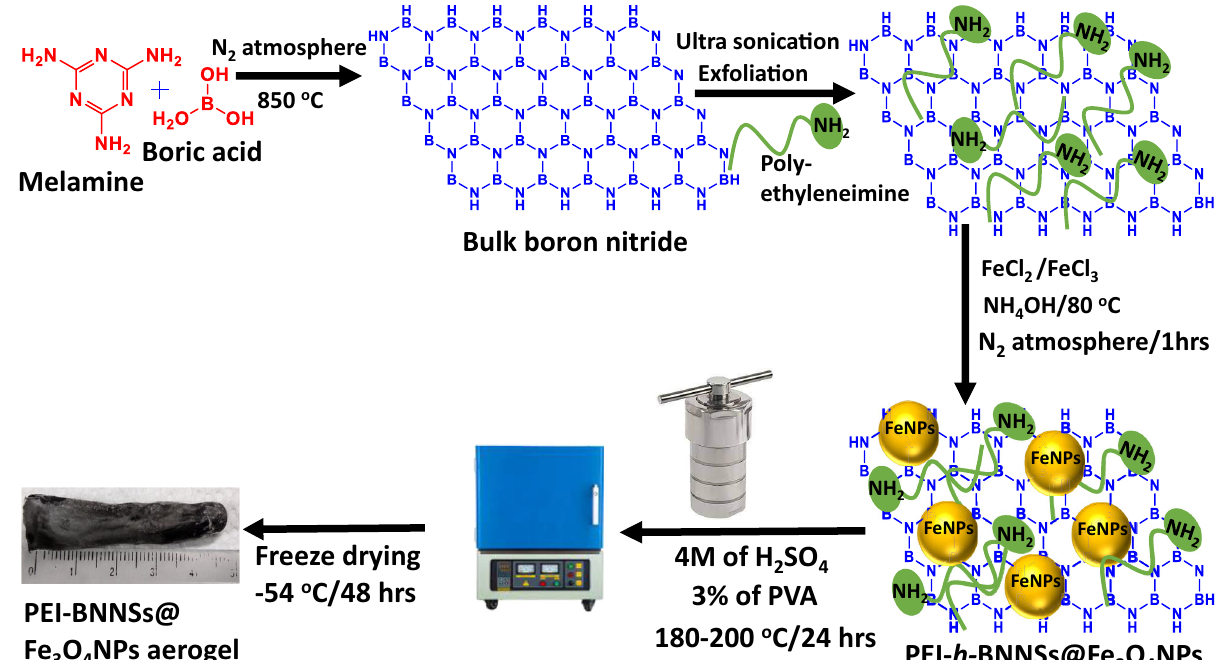
Fig. 1 Adsorbent preparation. The schematic illustration of detailed procedure for synthesis of magnetic hybrid aerogel (PEI- h - BNNSs@Fe 3 O 4